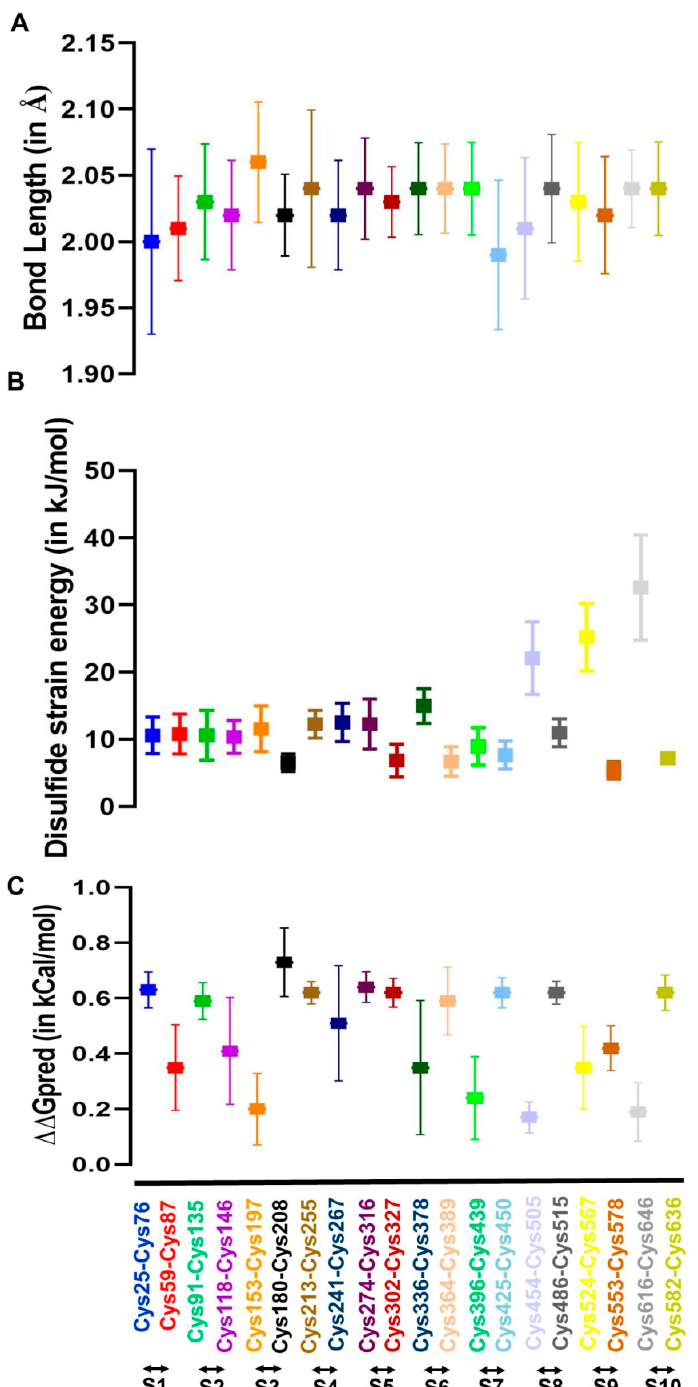
Figure 5. Evaluation of flexibility and stability of the disulfide bonds in the FXIII-B subunit monomer model. Panel A shows the variation in disulfide bond lengths during the simulation post equilibration of the FXIII-B subunit monomer model. Panel B shows the variation in disulfide strain energies of all disulfide bonds of the FXIII-B subunit monomer model during the MD simulation post-equilibration of the structure. Panel C shows the variability in free energy change when individual disulfide-bonded cysteines (the cysteines that have been mutated and expressed in this study) within the FXIII-B subunit monomer model are mutated to alanine. The evaluation was performed on several simulation trajectory structures (spaced at an interval of 20 ns) within the post-equilibrated simulation.